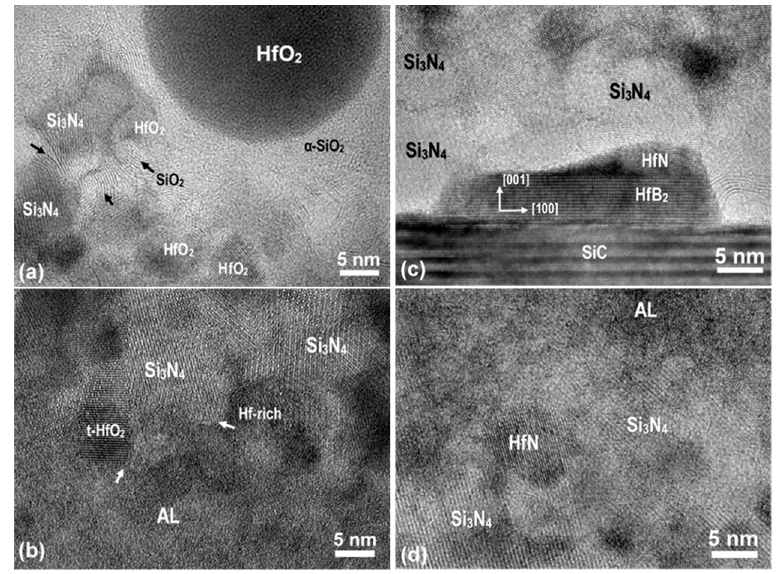
Figure 4. HRTEM image of the interface between the ( a ) oxide and transition layer, ( b ) amorphous and transition layer, ( c ) interlayer and SiC substrate and ( d ) interlayer and amorphous layer in the annealed Hf 6 B 10 Si 31 C 2 N 50 film.